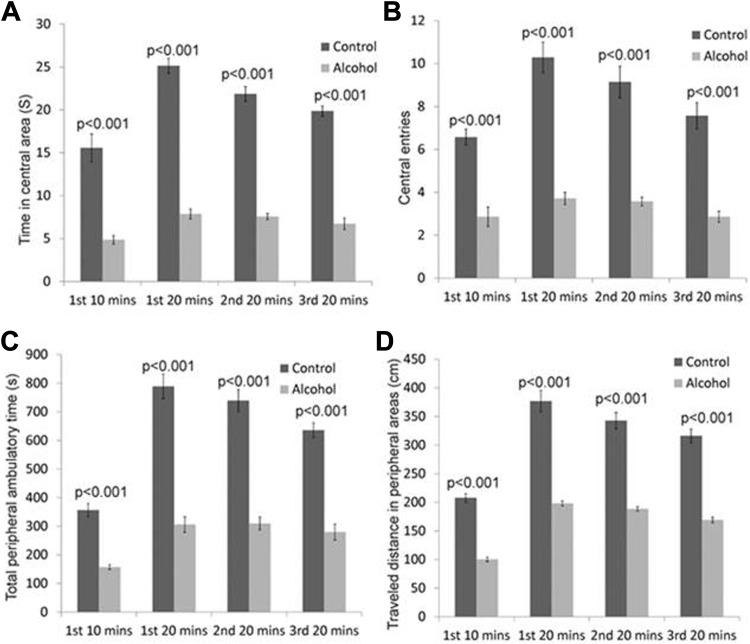
Comparison of locomotor activity by OFT between isocaloric and alcohol-treated mice (A) times in central areas, (B) numbers of central square entries, (C) total peripheral ambulatory time, and (D) traveled distance in peripheral area. Data are presented as mean ± standard error of the mean (n = 7). OFT indicates open field test.